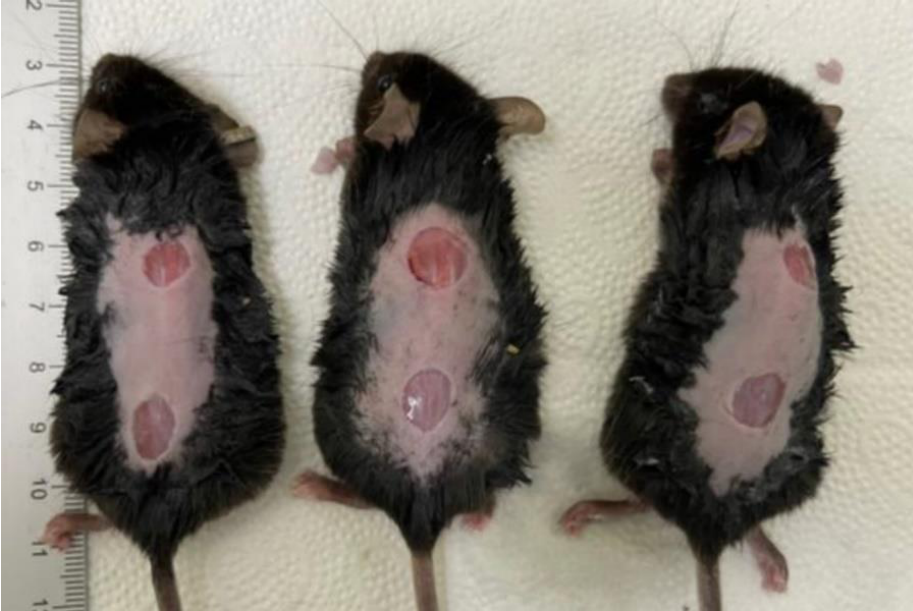
Figure 6. Creation of the diabetic wounds in C57BL/6 mice. Two circular wounds were created on the backs of mice using an 8-mm punch.